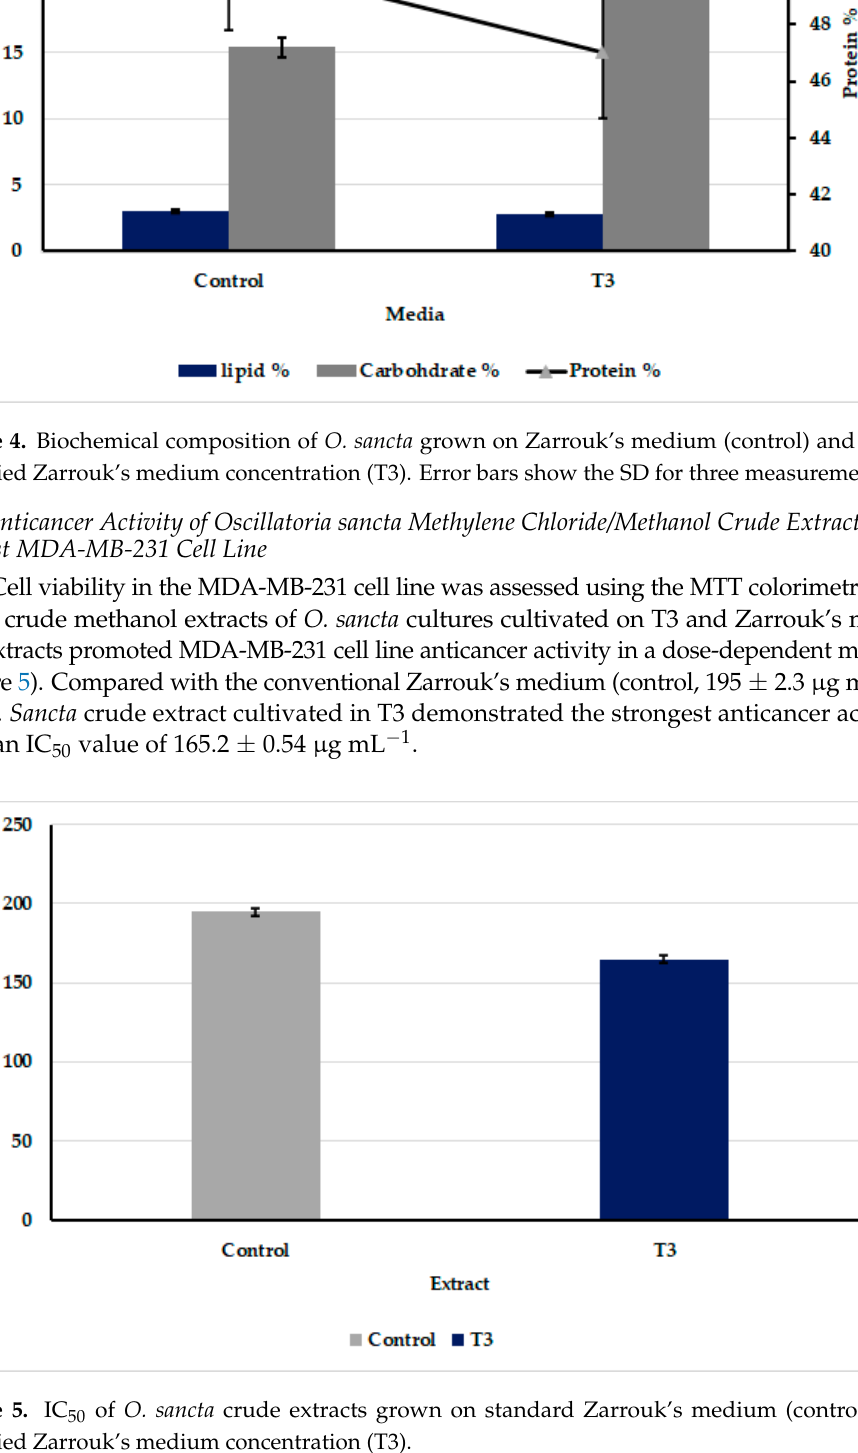
Table 3. The inhibition zone diameter (mm) measurement of different O. sancta crude extracts against pathogenic bacteria. Bacteria